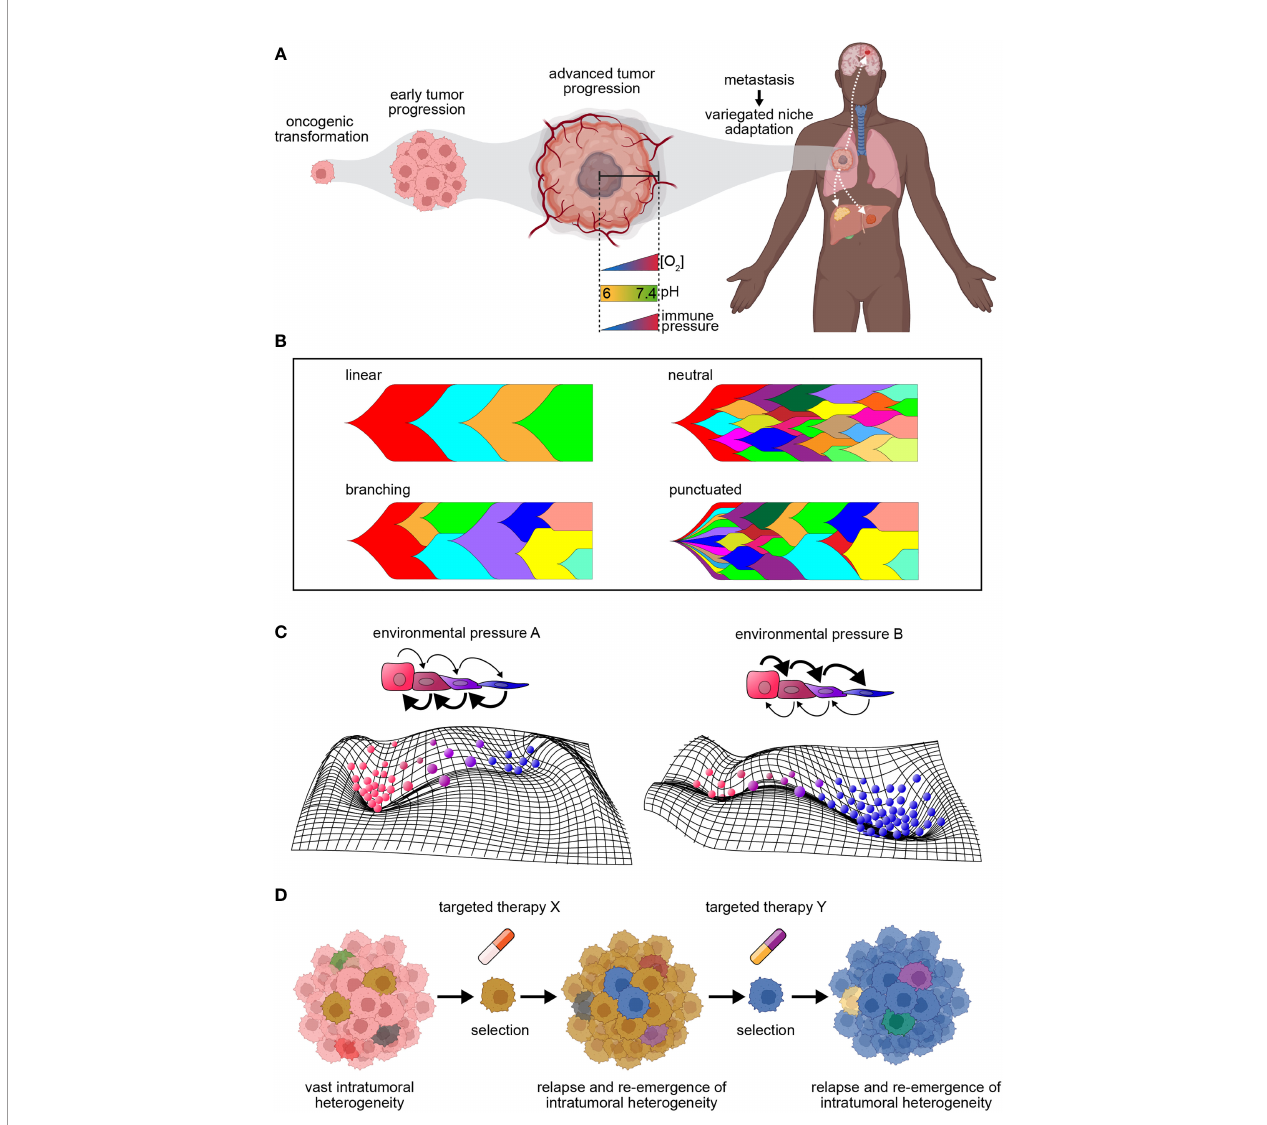
FIGURE 1 | Tumor dynamics in the context of progression and therapy. (A) Diagram illustrating the process of tumor progression beginning from a single founding clone. Tumor progression coincides with increasing intratumoral heterogeneity, and as metastasis occurs, clones exhibit variegated niche adaptation. (B) Models of tumor evolution. Linear evolution = mutations acquired in a stepwise fashion with driver mutations fueling selective sweeps of clonal dominance; branching evolution = clones evolve simultaneously, selecting for increased fi tness over time; neutral evolution = clonal expansion in absence of stringent selection leads to passive accumulation of genomic alterations; punctuated evolution = mutation bursts resulting in the sudden accrual of genomic changes. (C) Top: Schematic of cell state transitions in the presence of environmental pressures (A, B) . Arrows represent directionality of state transitions, where bold arrows represent increased transition rates. Color of cells corresponds to different cell states. Bottom: Representative cell state manifolds depicting in fl uence of above environmental pressures on modulating cell state. Peaks and troughs represent cell state stability. (D) Model depicting key limitations of targeted therapy. Intratumor heterogeneity serves as a sustainable source of resistance, fueling the survival of clones with drug tolerance or resistance throughout treatment. This drives tumor relapse and the re-emergence of intratumoral heterogeneity, resulting in a continuous